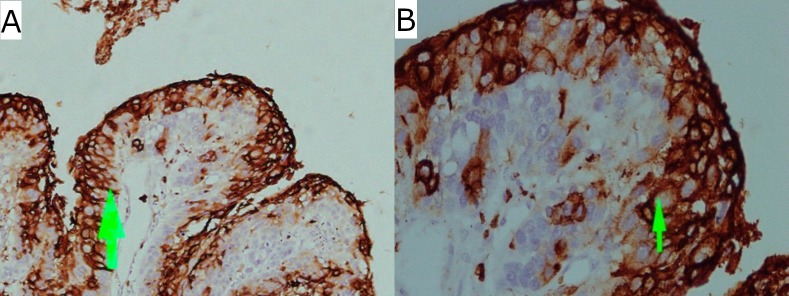
Immuno-histochemical expression of COX-2 in carcinoma in situ.Staining (membranous and cytoplasmic) in upper 2/3rd of mucosa (green arrow head) (A) at low power magnification (10x) (B) at high power magnification (40x).